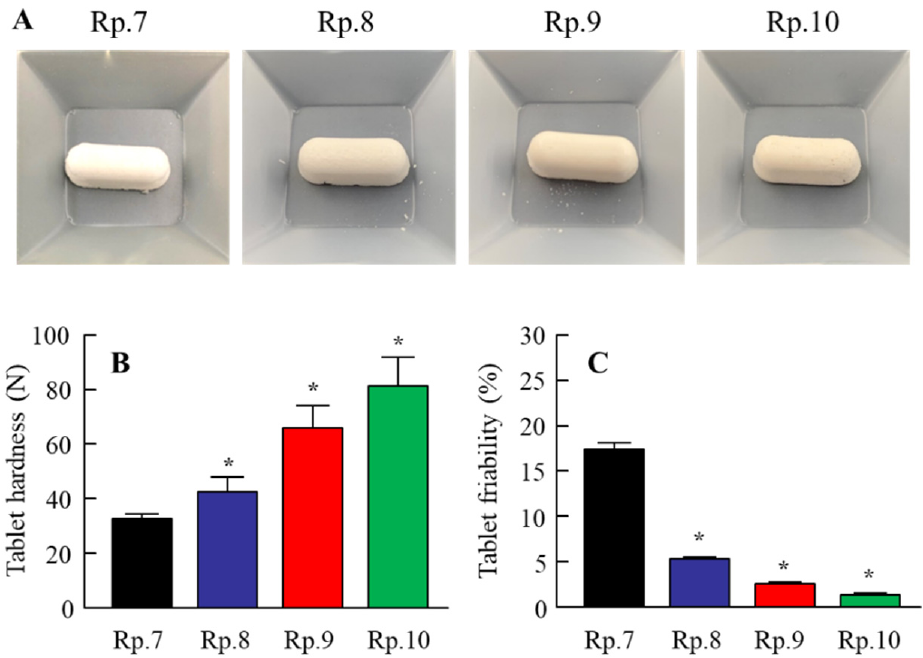
Figure 3. Effect of gum arabic on the hardness and friability of the IRB-NP tablets shown in Table 1. ( A – C ) Photograph ( A ), hardness ( B ), and friability ( C ) of the IRB-NP tablets (Rp.7–10). n = 10. * p < 0.05 vs. Rp.7 for each category. The hardness of the IRB-NP tablets increased with gum arabic con- tents. Moreover, the addition of gum arabic decreased the friability of the IRB-NP tablets.